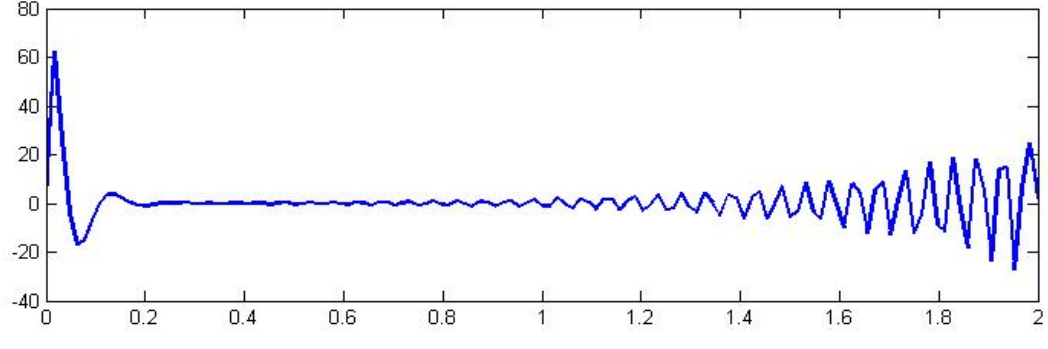
Figure 2. Graph of solution of Example 2 for N=128 and